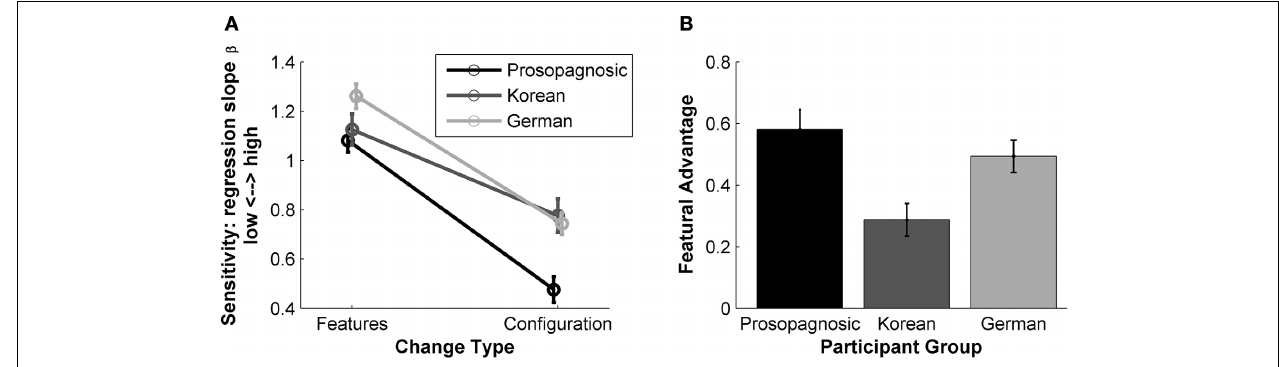
FIGURE 7 | Results of the similarity rating experiment. (A) Mean values of slopes ( β ) for the “feature” and “configuration” regression lines for each group Error bars: SEM. (B) “featural advantage”: mean difference between configural and featural regression slopes ( β ) calculated for each participant. Error bars: